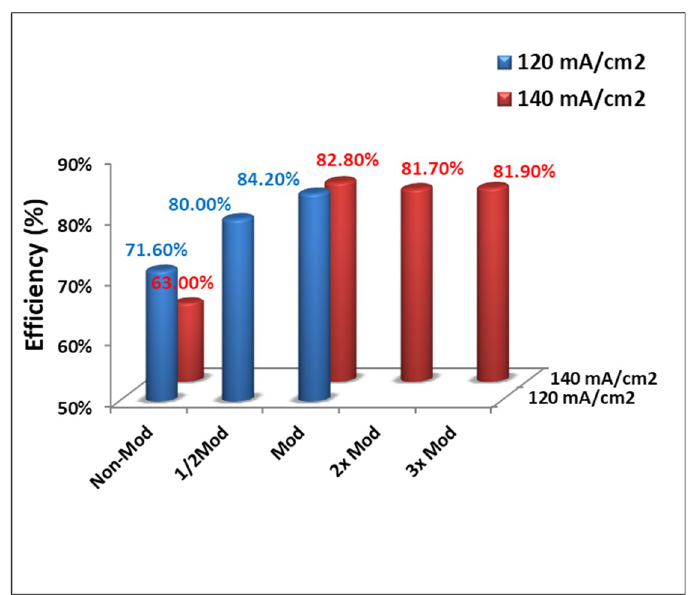
Figure 3. Efficiency (%) performance of the single cell equipped with the different parameters of Figure 3. E ffi ciency (%) performance of the single cell equipped with the di ff erent parameters of atmospheric plasma treated carbon felt. atmospheric plasma treated carbon felt.